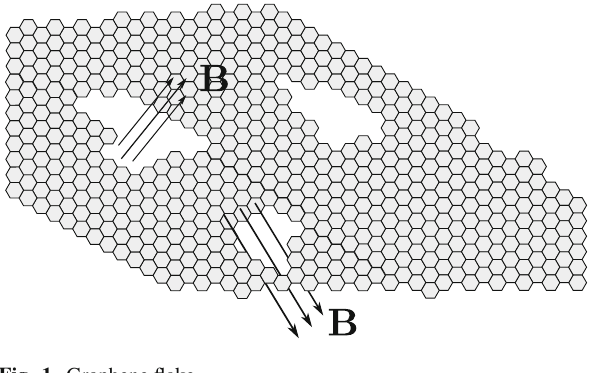
Fig. 1 Graphene flake